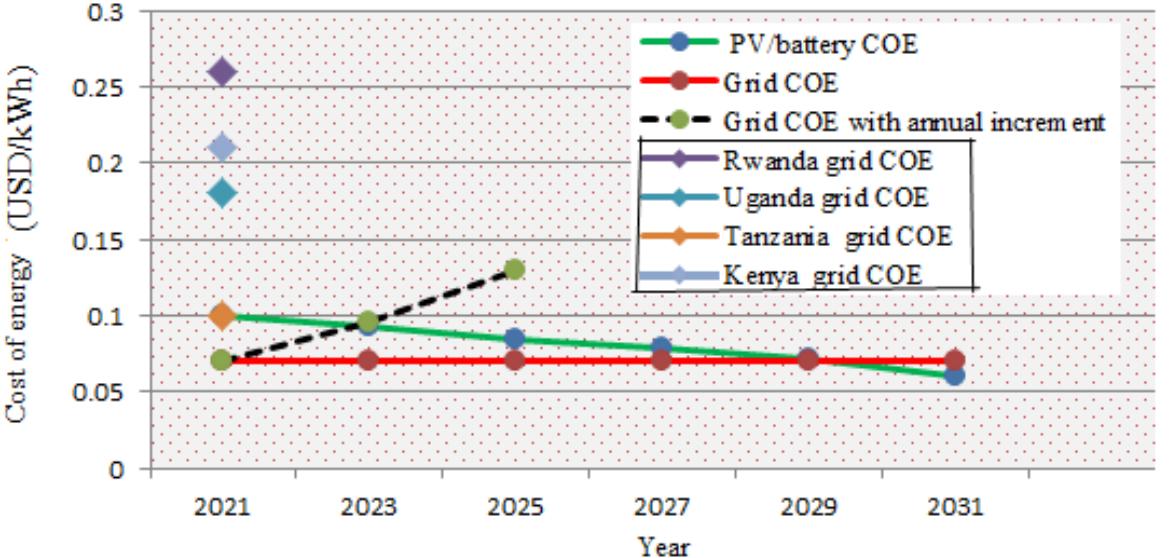
Figure 11. Comparison of the PV/battery’s COE with the grid’s COE.